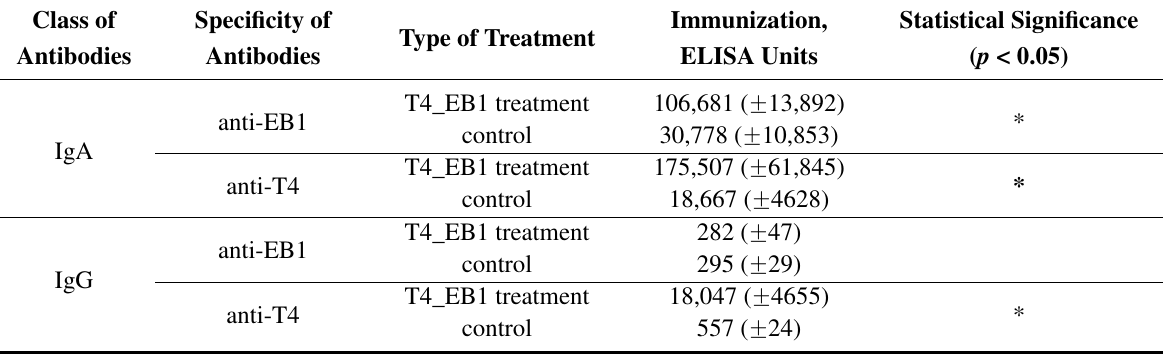
Table 1. Induction of antibodies specific to the foreign antigen EB1 presented on T4 phage, after oral application of the phage. Mice were treated with the EB1 presenting phage in drinking water, control mice were not treated with phage or EB1 antigen, specific IgA and IgG levels were presented as mean ELISA units in groups (with SD); T4 phage specific antibodies served as a positive control of immunization. Statistically significant differences were marked with